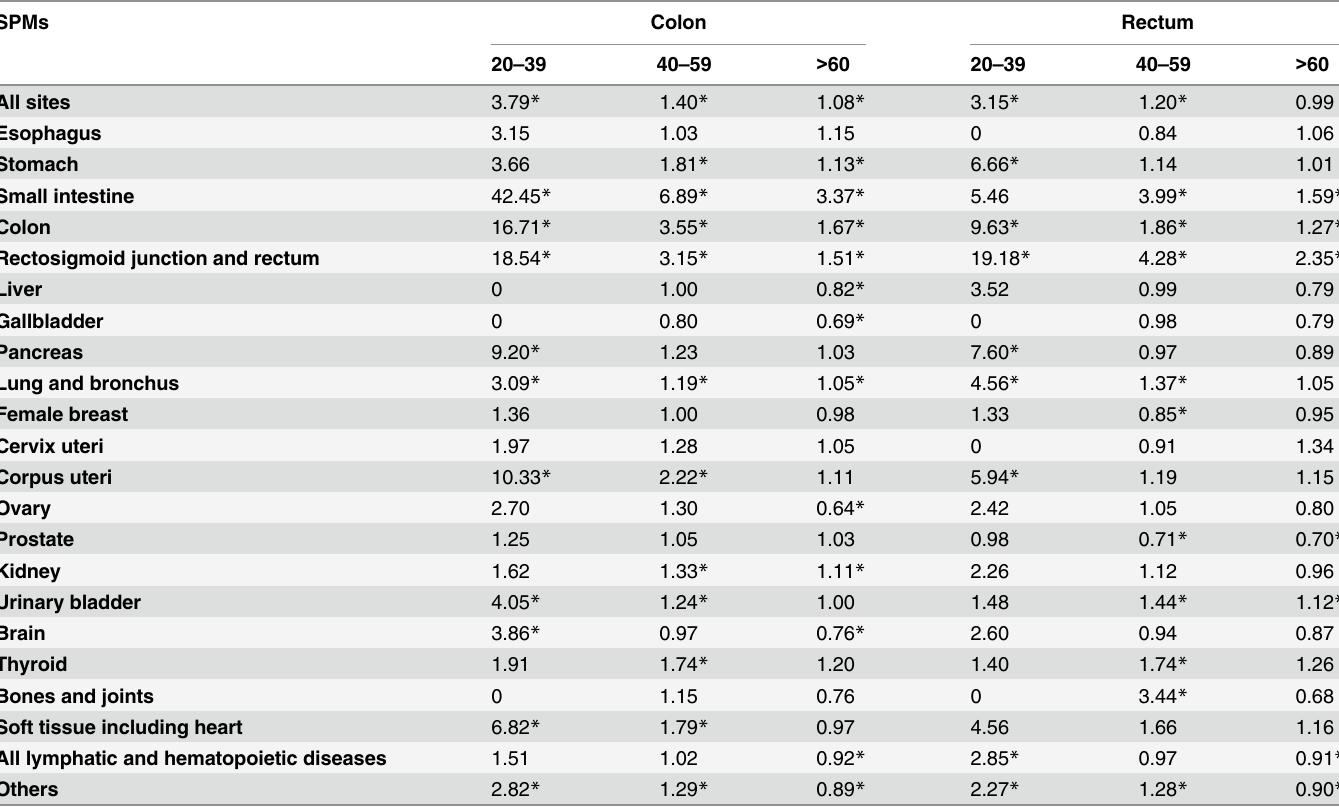
Table 3. SIRs of SPMs in colon and rectal cancer patients, by age.